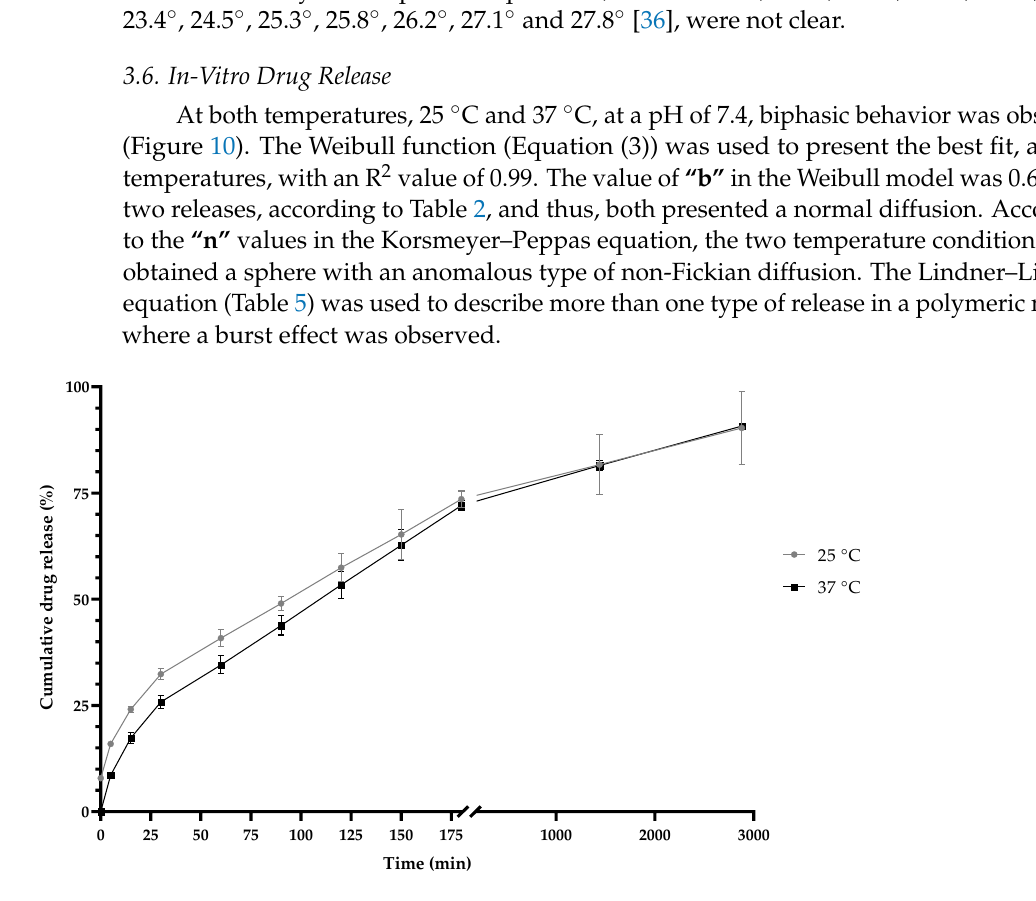
Figure 10. Release kinetics of inulin nanoparticles loaded with quercetin (NQs) at a pH of 7.4 and at different temperatures (25 °C (gray line) and 37 °C (black line)) at 2880 min (48 h). Table 5. Mathematical models used for the prediction of kinetic release in the first 3 h.